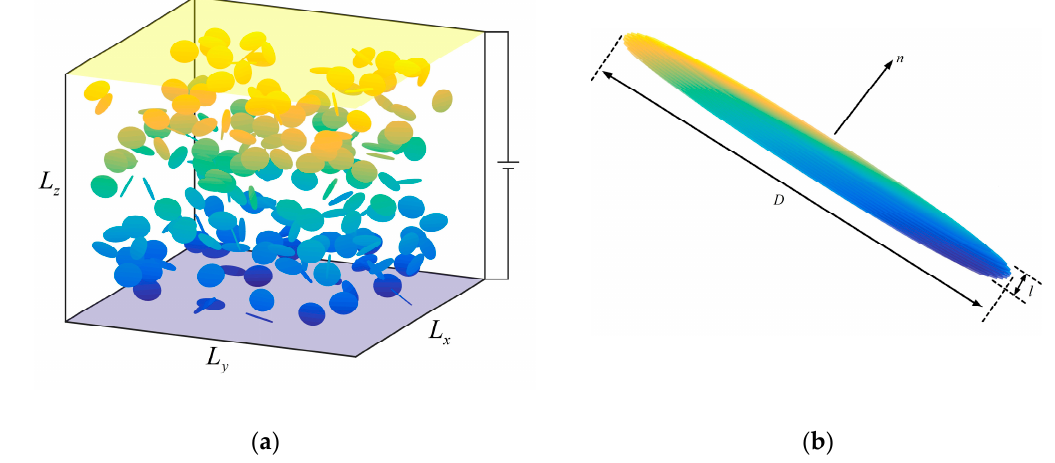
Figure 1. Schematics of ( a ) graphene nanoplatelet (GNP) network in a representative volume element (RVE) and ( b ) position and orientation of the GNP.